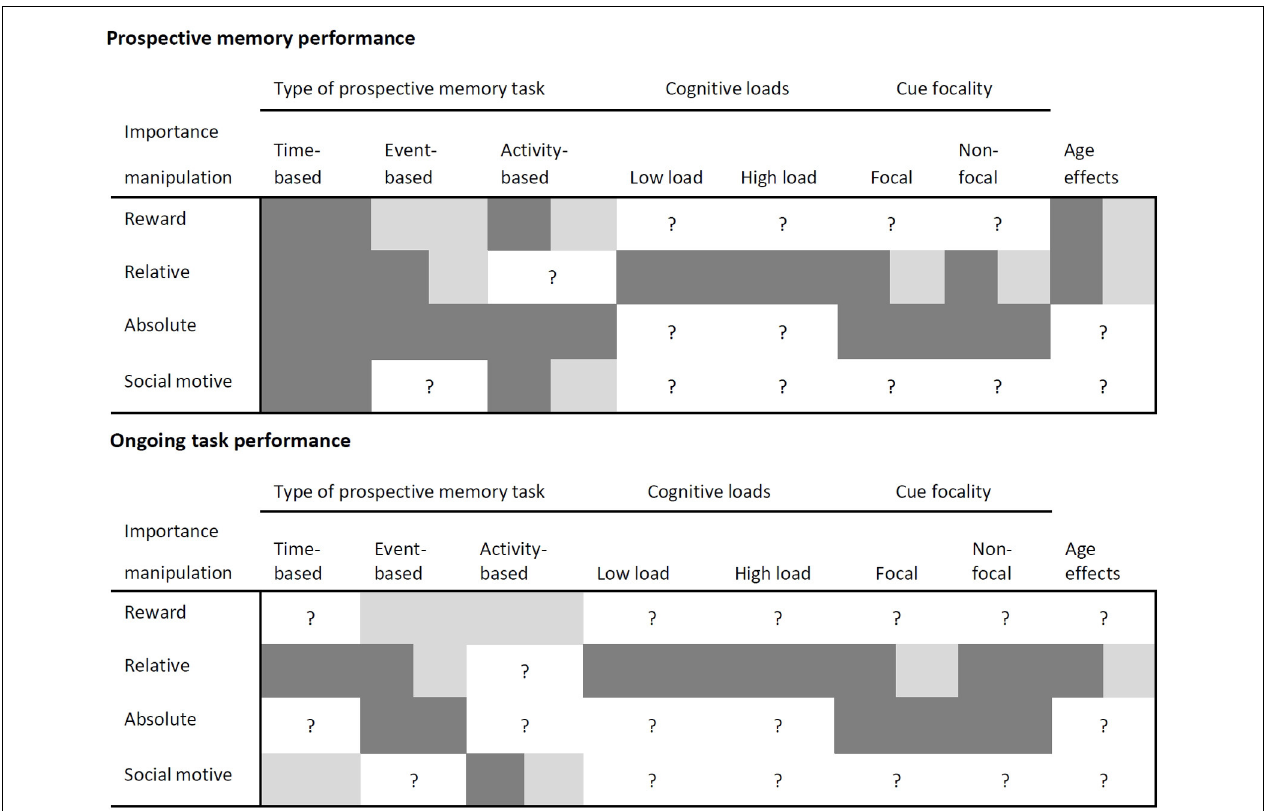
FIGURE 1 | Effects of importance on prospective memory performance and on ongoing task performance depending on the kind of importance manipulation, type of prospective memory task, cognitive loads, cue focality, and age. Dark gray fields show